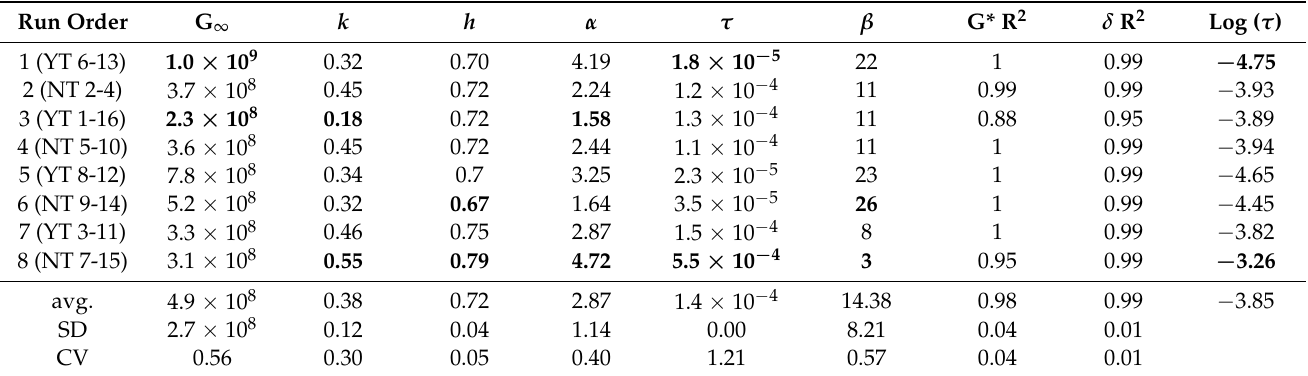
Table 13. The 2S2P1D model parameters for all runs for 160/220_II. Statistically significant differences between runs are denoted in